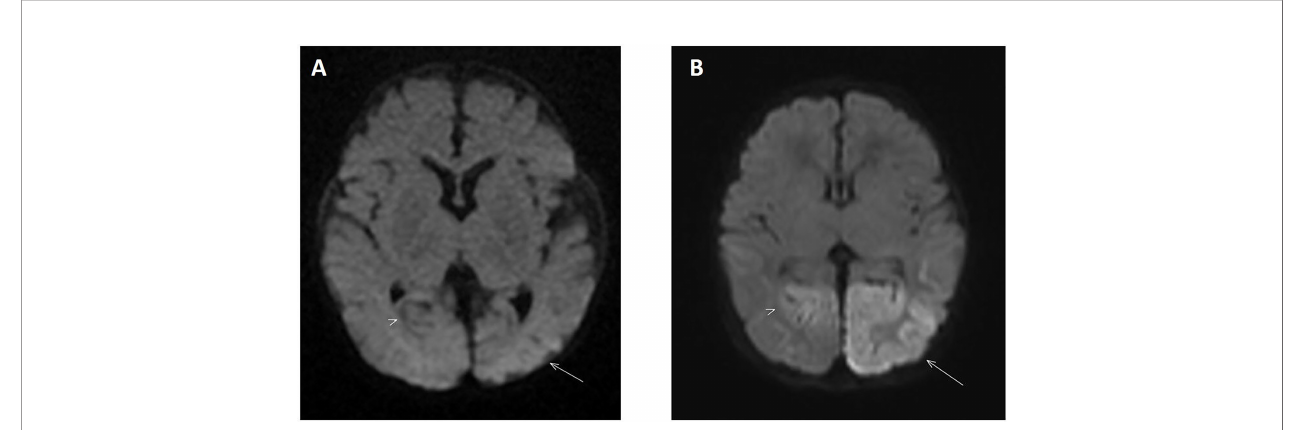
FIGURE 2 | (A) Diffusion-weighted MRI on day 4 of life showing increased signal intensity located in the left occipital lobe (arrow) consistent with an area of restricted diffusion. The right occipital lobe is also involved to a lesser extent (arrowhead). These fi ndings are consistent with severe symptomatic hypoglycemia when correlated to clinical and laboratory investigations. (B) Diffusion-weighted MRI performed 2 months later shows resolution of the restricted diffusion in the previously involved areas. However, there is now residual atrophy in both occipital lobes with the left side more severely involved compared to the right (arrow and arrowhead respectively).